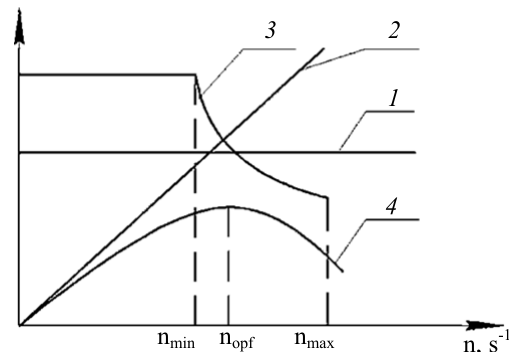
Fig. 4. Dependence of the final concentration of the mixture of curd whey and chokeberry extracts from the rotor speed of the evaporator.